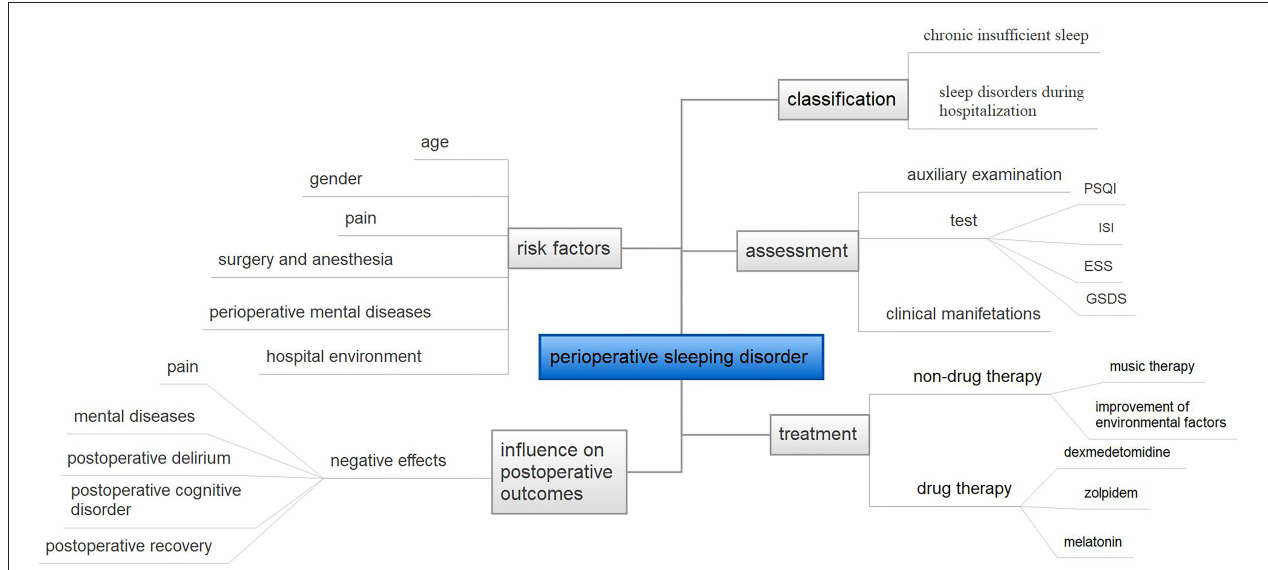
FIGURE 1 | The overview of this paper. PSQI, Pittsburgh Sleep Quality Index questionnaire; ISI, Insomnia Severity Index; ESS, Epworth Sleepiness Scale; GSDS, General Sleep Disturbance Scale.